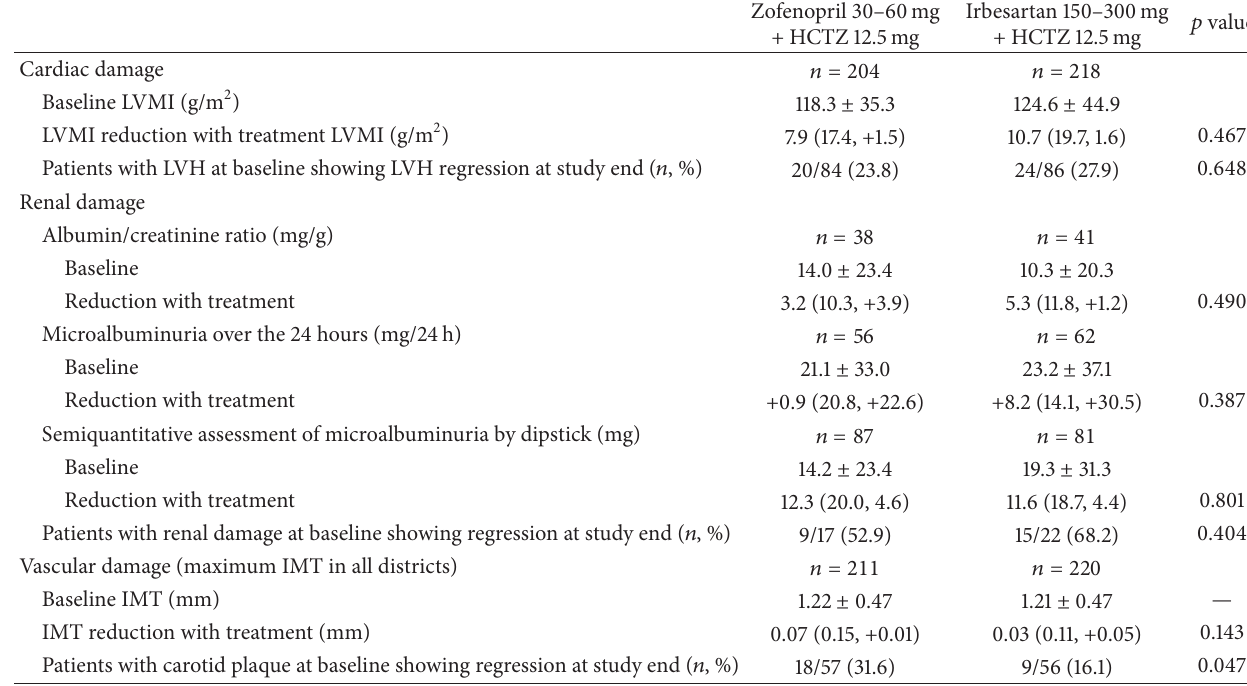
Table 3: Summary measures for cardiac (LVMI, left ventricular mass index), renal (urine protein), and vascular (IMT, intima-media thickness) damage for the intention-to-treat population and for the two study treatment groups. For any measure the baseline value ( ± SD), the adjusted reduction (and 95% confidence interval), and the absolute ( 𝑛 ) and relative (%) frequency of patients with damage at baseline showing regression with treatment are reported. Adjustment was made by the baseline value and other potentially confounding variables (age, gender, abdominal obesity, HDL cholesterol, family history for premature cardiovascular disease, baseline blood pressure, and blood pressure changes with treatment). The 𝑝 value refers to the statistical significance of the intertreatment difference.